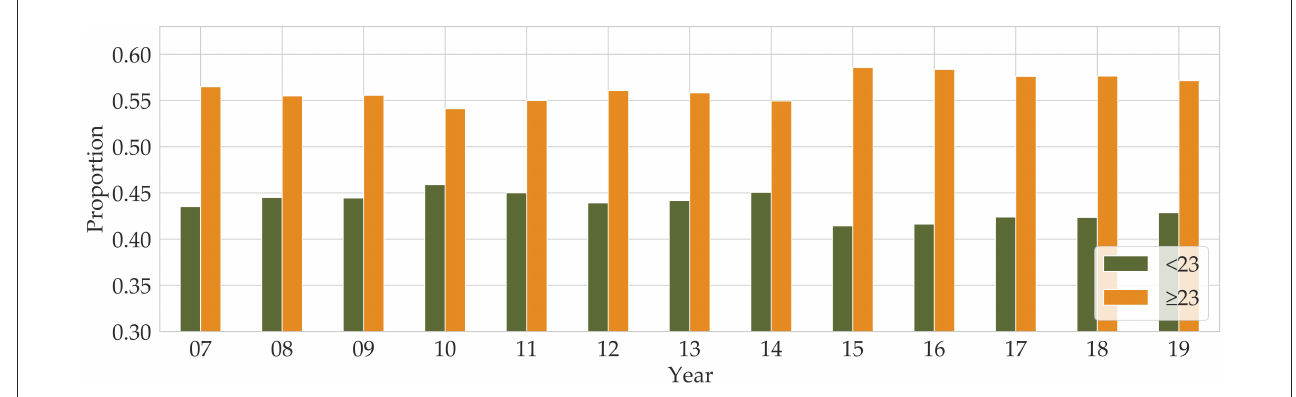
FIGURE1 Annual proportions of BMI below and above 23 are shown from 2007 to 2019 (Orange for BMI above 23 and green for BMI below